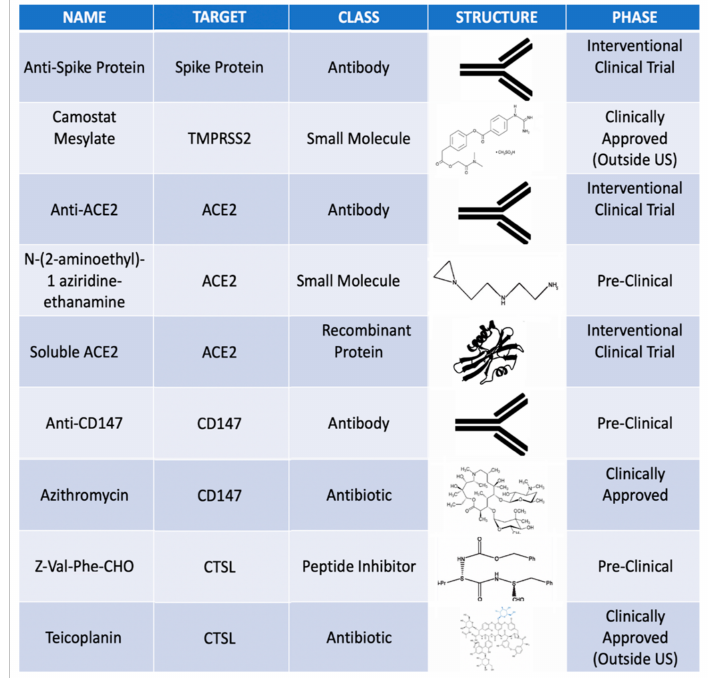
Figure 6. Potential topical ocular medications targeting specifically TMPRSS2, ACE-2, CD147 and